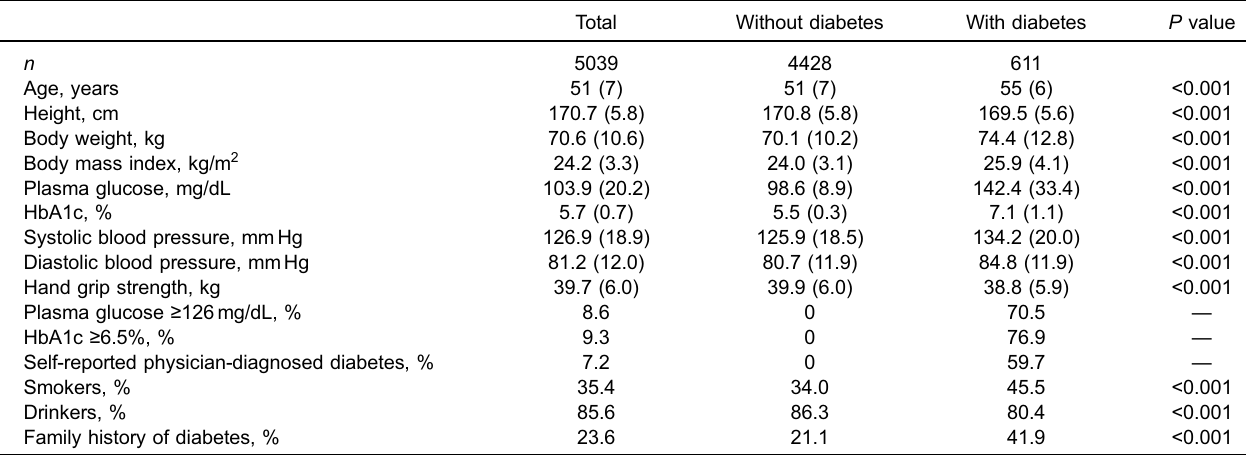
Total Without diabetes With diabetes P value